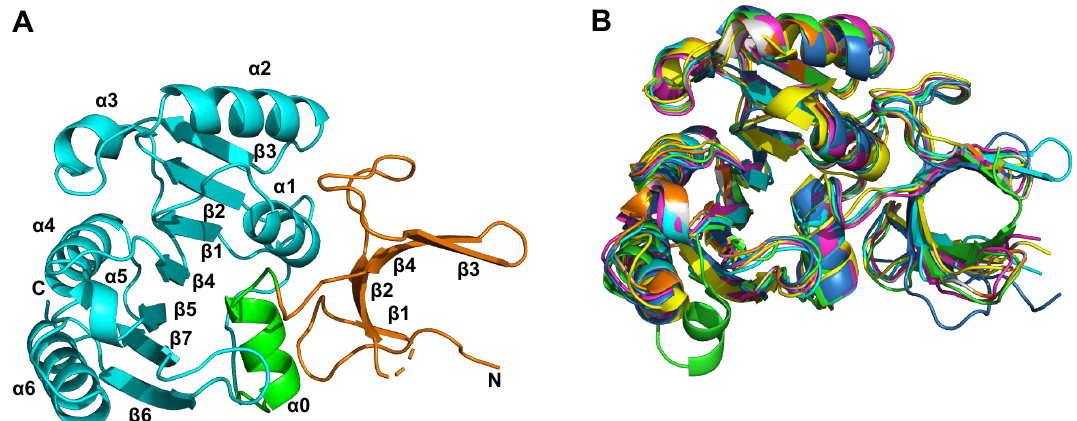
Figure 1. hFBL crystal structure. ( A ) Structure of hFBL (cartoon representation). The crystal structure consists of 11 β -strands and 7 α -helices that fold into an N-terminal (orange) and a C-terminal (cyan) domain and a short connecting helix (a0, green). ( B ) Superposition of representative FBL orthologs from Aeropyrum pernix (green, PDB ID 4DF3), Methanocaldococcus jannaschii (blue, PDB ID 1G8S), Pyrococcus furiosus (purple, PDB ID 3NMU), Saccharolobus solfataricus (orange, PDB ID 3PLA), Chaetomium thermophilum (grey, PDB ID 5JPQ), and Saccharomyces cerevisiae (yellow, PDB ID 6ND4) are shown.